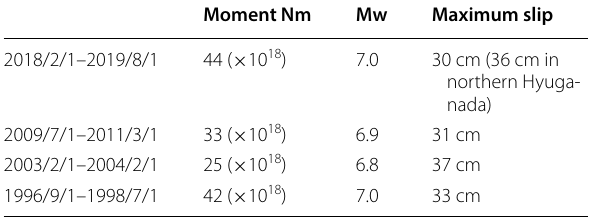
Table 1 The estimated moment, moment magnitude (Mw) and maximum slip for the past four major Bungo channel